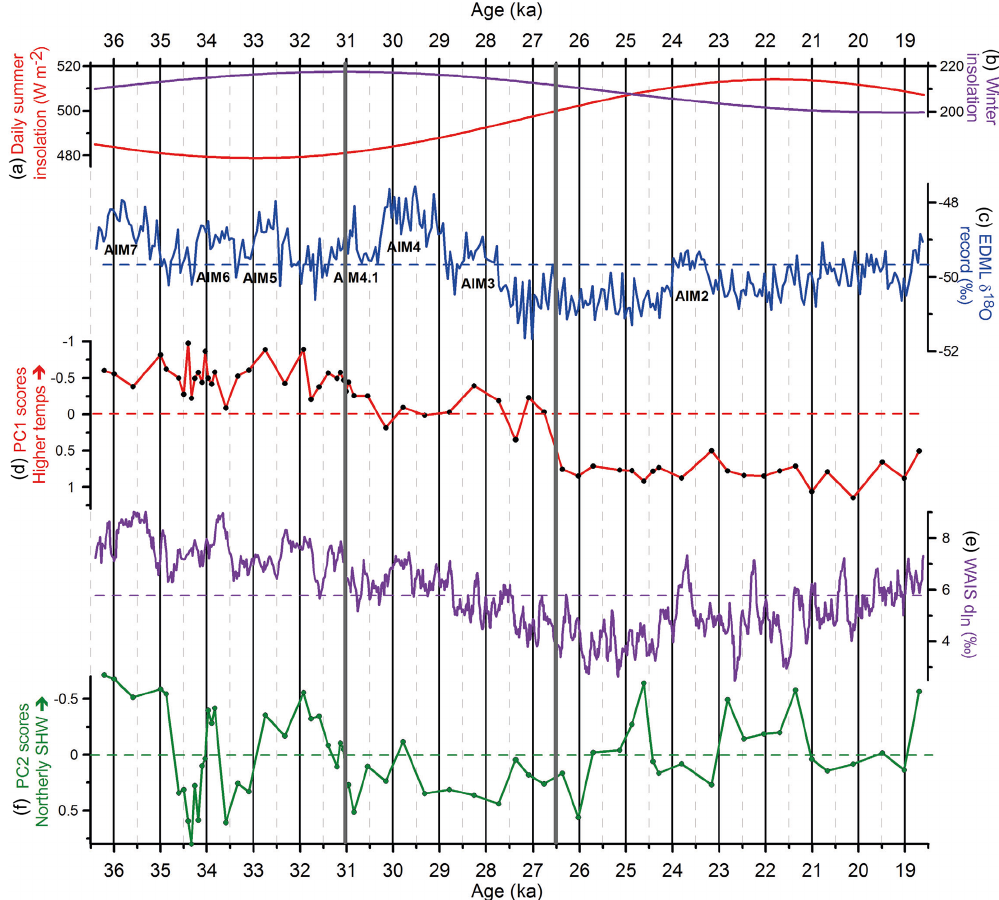
Figure 11. Comparison between our PC1 and PC2 records and other relevant data. (a, b) Mean daily summer and winter insolation at 37 ◦ S (Laskar et al., 2004). (c) EDML δ 18 O record (EPICA Community Members et al., 2006) with Antarctic Isotope Maxima (AIM). (d) PC1 scores implying temperature shifts at NI. (e) WAIS d ln values from west Antarctica (Markle et al., 2016). (f) PC2 scores indicate impact of SHW at NI. Note that sample levels, i.e., time resolution, for the PC records are shown as dots. Note the two thick gray lines (31 and 26.5ka) indicating the position of the three PCA zones (Fig.